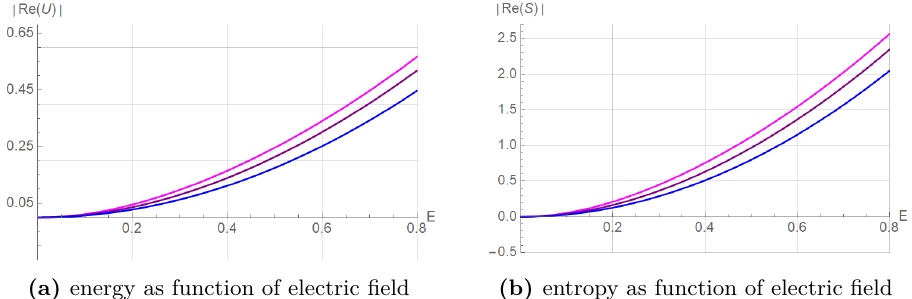
Figure 3. For the charged spinor, we calculate the finite parts of the energy U and entropy S as function of the electric field E as we did for the scalar in figure 2. The main difference is that for spinors, U and S are both monotonic as function of electric field E , which was not the case for scalars. From magenta to blue we have m = 0 . 2 , 0 . 5 , 1